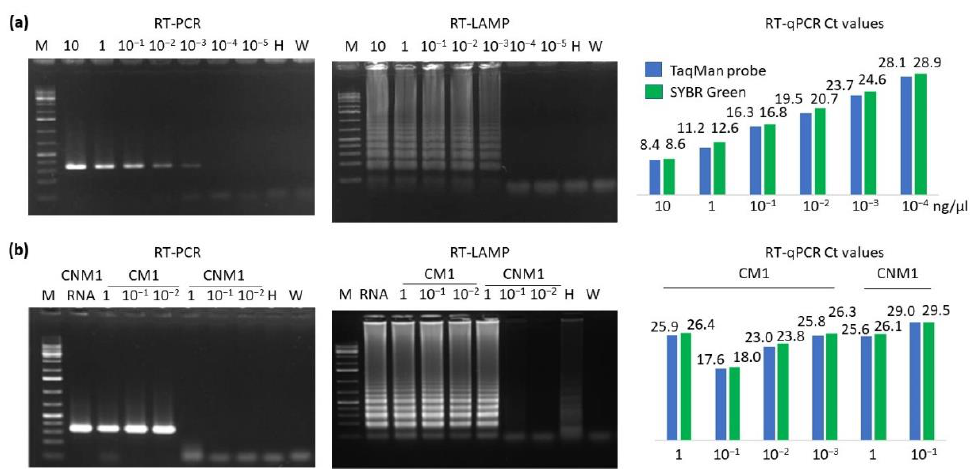
Figure 3. Evaluation of XYDV detection techniques: ( a ) sensitivity assessed using serial dilutions of 10 ng/ µ L RNA extracts; ( b ) serial dilutions of plant crude extracts from two XYDV isolates, CM1 and CNM1. CMN1 RNA was used as an RT-PCR positive control. M = GeneRuler 1 kb plus ladder (Thermo Fisher Scientific, Waltham, MA, USA). Negative controls: H = RNA or crude extracts from C. esculentus healthy plants and W = water. No amplifications were obtained with RT-qPCR of the negative controls.